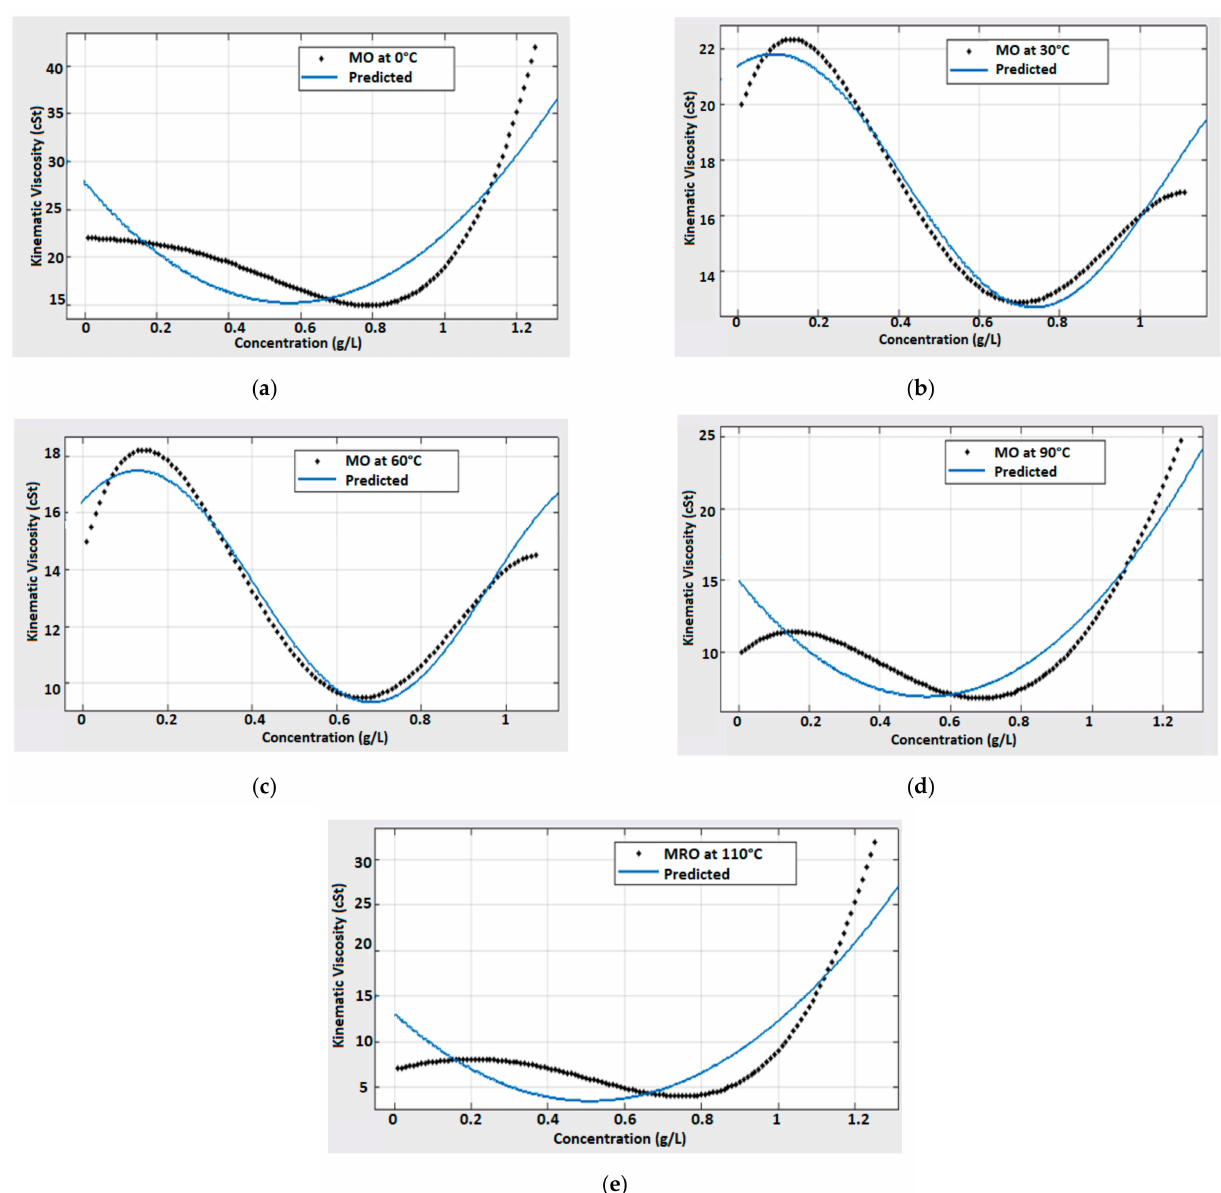
Figure 12. Comparison of measured and predicted kinematic viscosity of MO using Lagrange polynomial interpolation function and Fourier distribution function. The predicted value showing deviation of ± 1 cSt and 0.6 ± 0.2 g/L from the